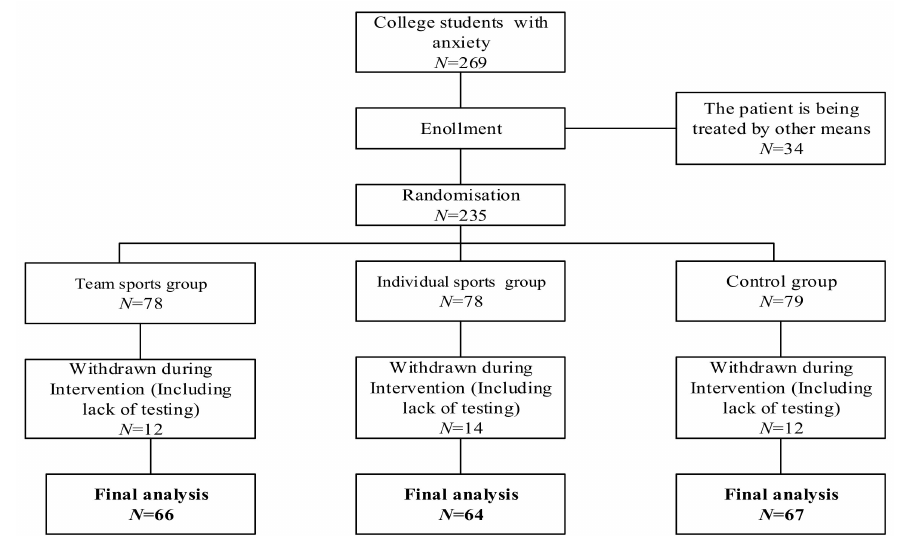
Figure 1. Participant flowchart across the